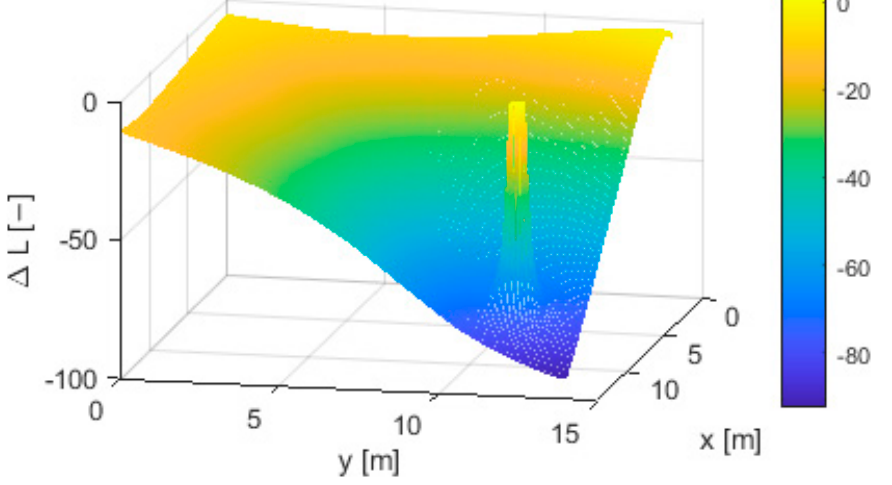
Figure 12. Interest zone enlargement of the results of the Lyapunov incremental function ∆𝐿 over the entire navigation area for Agent K.